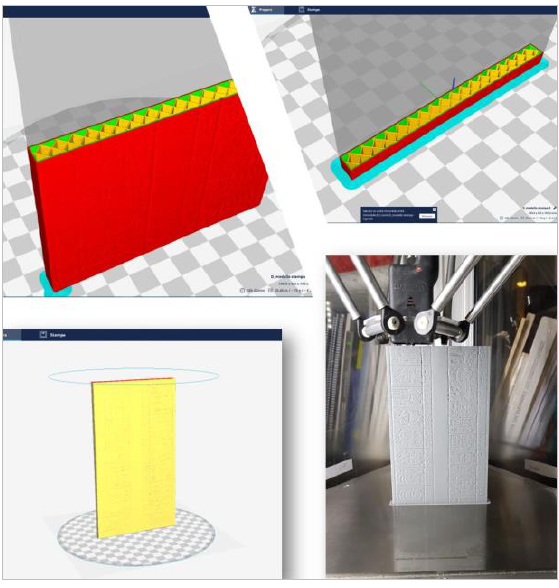
Figure 9: The creation of G-Code file and print phase of